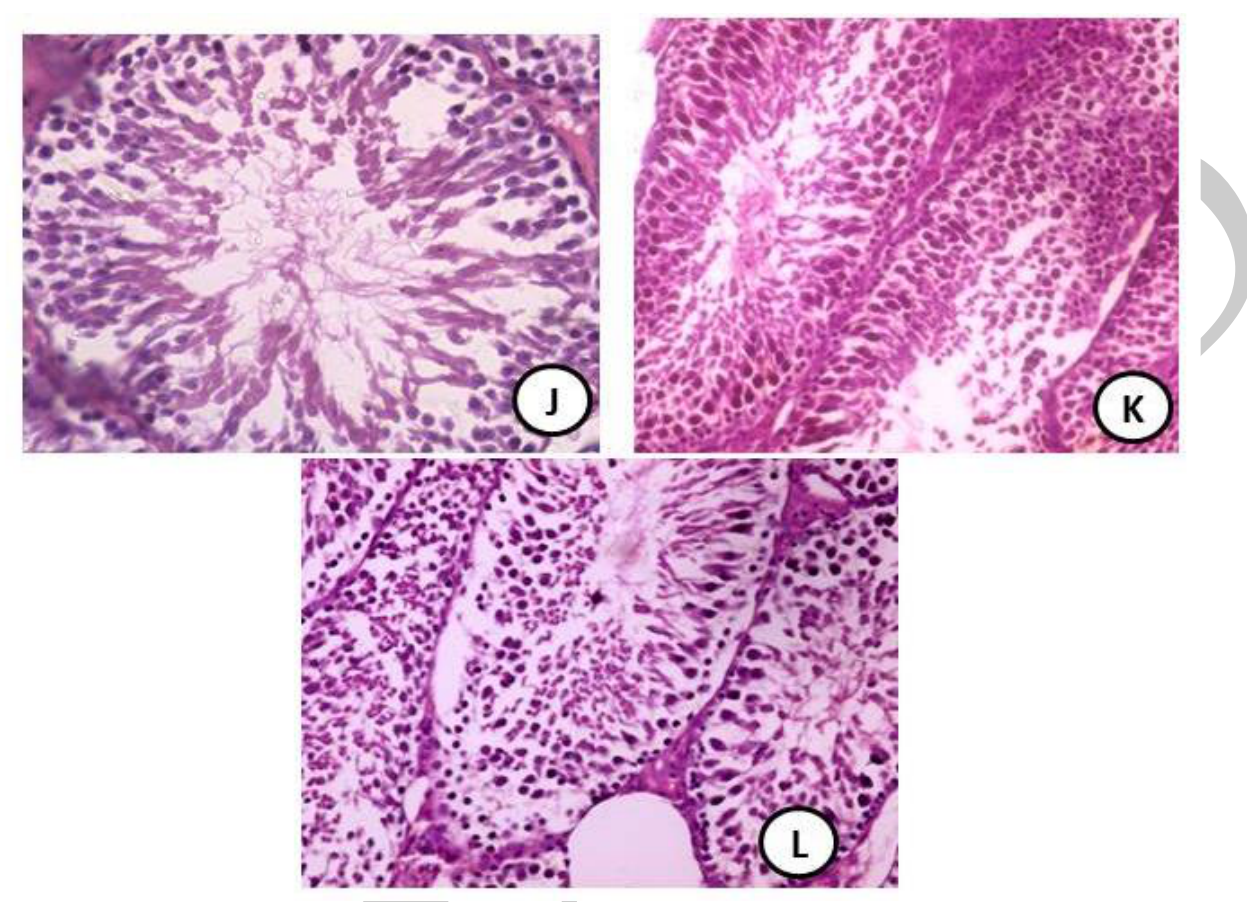
Figure 5. Cross sections of mice testis tissues from the treated groups showing structure alterations H&E stain X400: ( A ) the testicular tissues from the control group showed a normal appearance and showed normal seminiferous tubules (ST) with normal spermatogenic cells (black arrow) (H&EX400); ( B1 , B2 ) DG group showed a testis section of a group treated with DG showing degeneration of most parts of the seminiferous tubules (***) with oligospermia (red arrow) and hyperplasia of spermatogonia (H&EX400); ( C ) CH-NPs (high dose) group showed a normal spermatogonia (yellow arrow) with a lot of sperms (***); ( D ) CH-NPs (low dose) group showed a normal spermatogonia (***) with a lot of sperms (green arrow) and an appearance of plenty of sperms (H&EX400); ( E ) RV group showed a normal spermatogonia (blue arrow) and normal seminiferous tubules and ledyig cells (H&EX400); ( F ) Q group showed a normal spermatogonia (red arrow) with plenty of sperms (***) (H&EX400); ( G ) CH-NPs (low dose) + RV group showed a normal spermatogonia (red arrow) with plenty of sperms (***) and ledyig cells (H&EX400); ( H ) CH-NPs (high dose) + RV group showed a normal spermatogonia (blue arrow) with plenty of sperms (***) (H&EX400); ( I ) CH-NPs (low dose) + Q group showing a normal spermatogonia (red arrow) (H&EX400) ; ( J ) CH-NPs (high dose) + Q group showed a normal spermatogonia (red arrow) (H&EX400); ( K ) DG + CH-NPs (low dose) + RV + Q showed restoration of spermatogonia layers (black arrow) and plenty of sperms (H&EX400); ( L ) DG + CH-NPs (high dose) + RV + Q showed high restoration of spermatogonia layers (black arrow) and plenty of sperms (H&EX400).